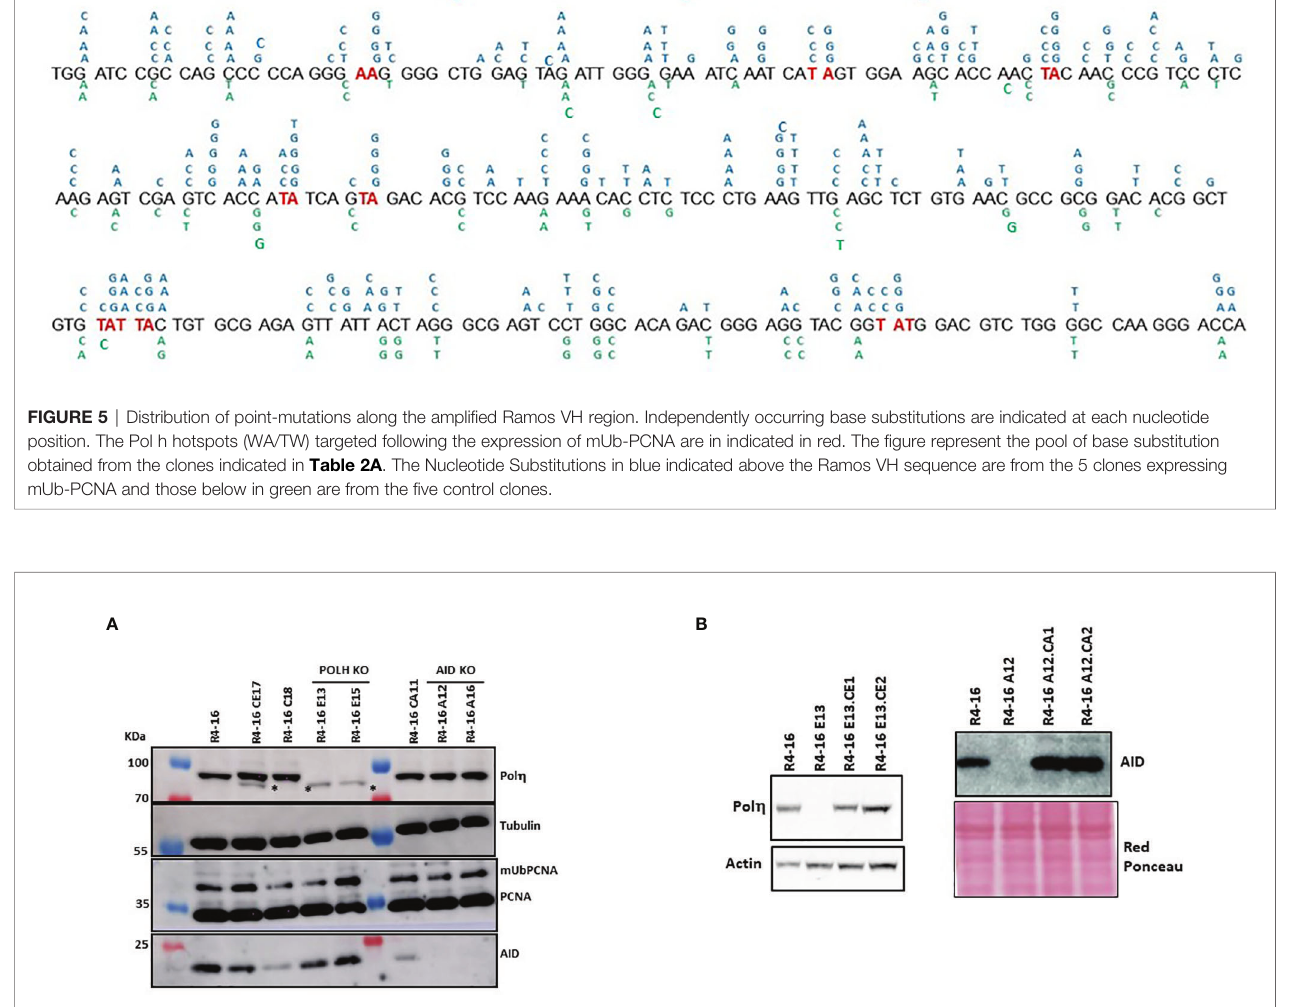
FIGURE 6 | Inactivation and restoration of pol h and AID in the R4-16 clone. CRISPR/Cas9 was used to inactivate and gRNA editing were used to inactivate pol h or AID. (A) The absence of the corresponding proteins was con fi rmed in two selected clones by immunoblot analysis. (B) KO clones were reconstituted by stable expression of POLH or AID cDNA. Left panel: R4-16E13-CE1 and R4-16E13-CE2 are two clones derived from the human pol h de fi cient clone R4-16E13 after transfection with pol h -expressing vector. Right panel: R4-16A12-CA1 R4-16A12-CA2 are two clones derived from the AID-de fi cient clone R4-16A12 after transfection with the human AID-expressing vector. Actin and red Ponceau staining were used as loading controls. *Nonspeci fi c